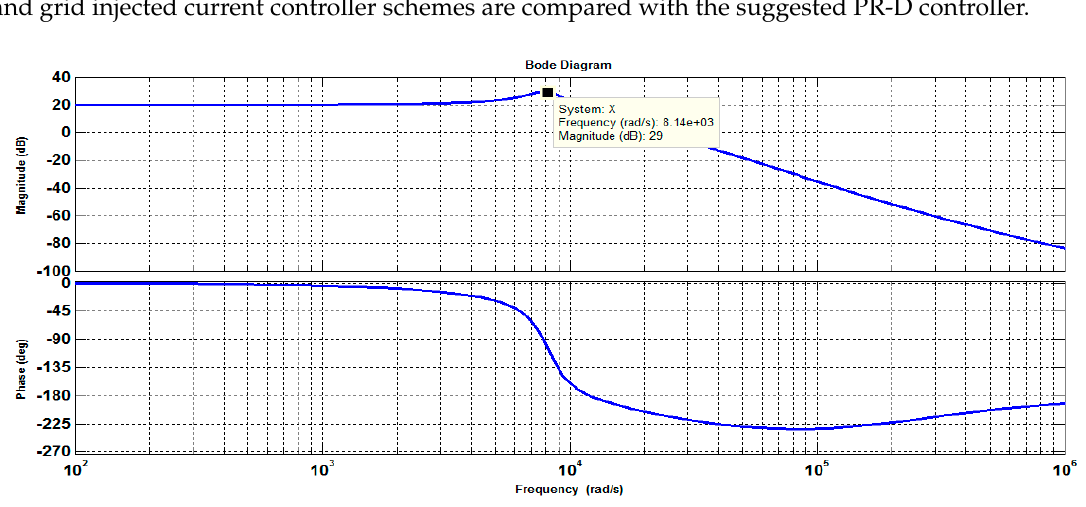
Figure 17. Grid output voltage harmonic profile.